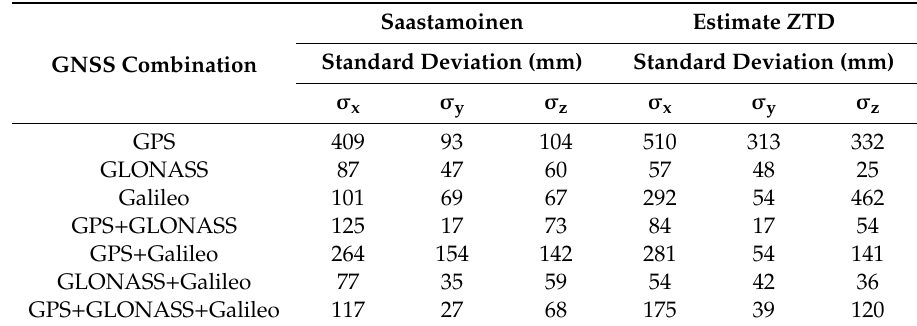
Table 2. Standard deviation of the considered GNSS combinations with Saastamoinen and Estimate ZTD (Zenith Troposhperic Delay) tropospheric models.